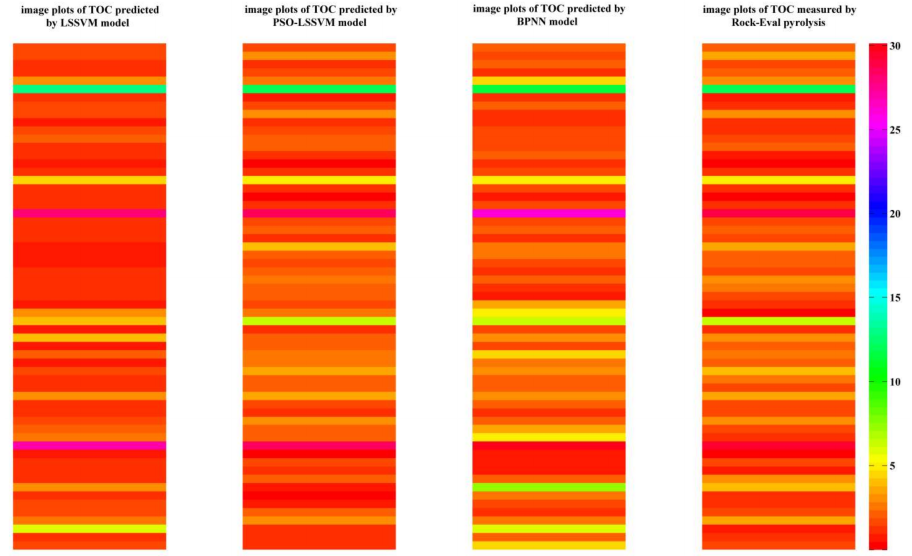
Figure 10. Image plots showing the graphical comparison between the measured and predicted TOC by the different prediction models. The predicted TOC by PSO-LSSVM model were shown to be extremely consistent with the actual measure TOC in Well